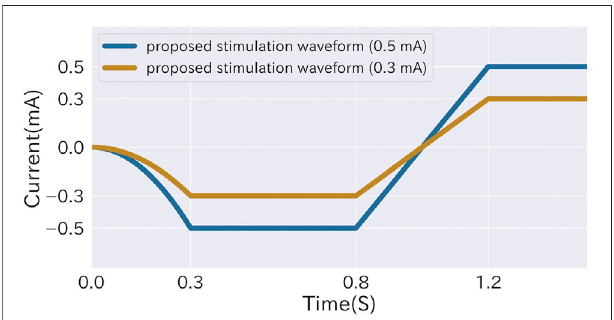
FIGURE1 | Proposed stimulation waveform. 0.3 sease-in wasfollowed by a 0.5 mA (0.3 mA) cathodal stimulation for 0.5 s. Then, 0.5 mA (0.3 mA) anodal stimulation was